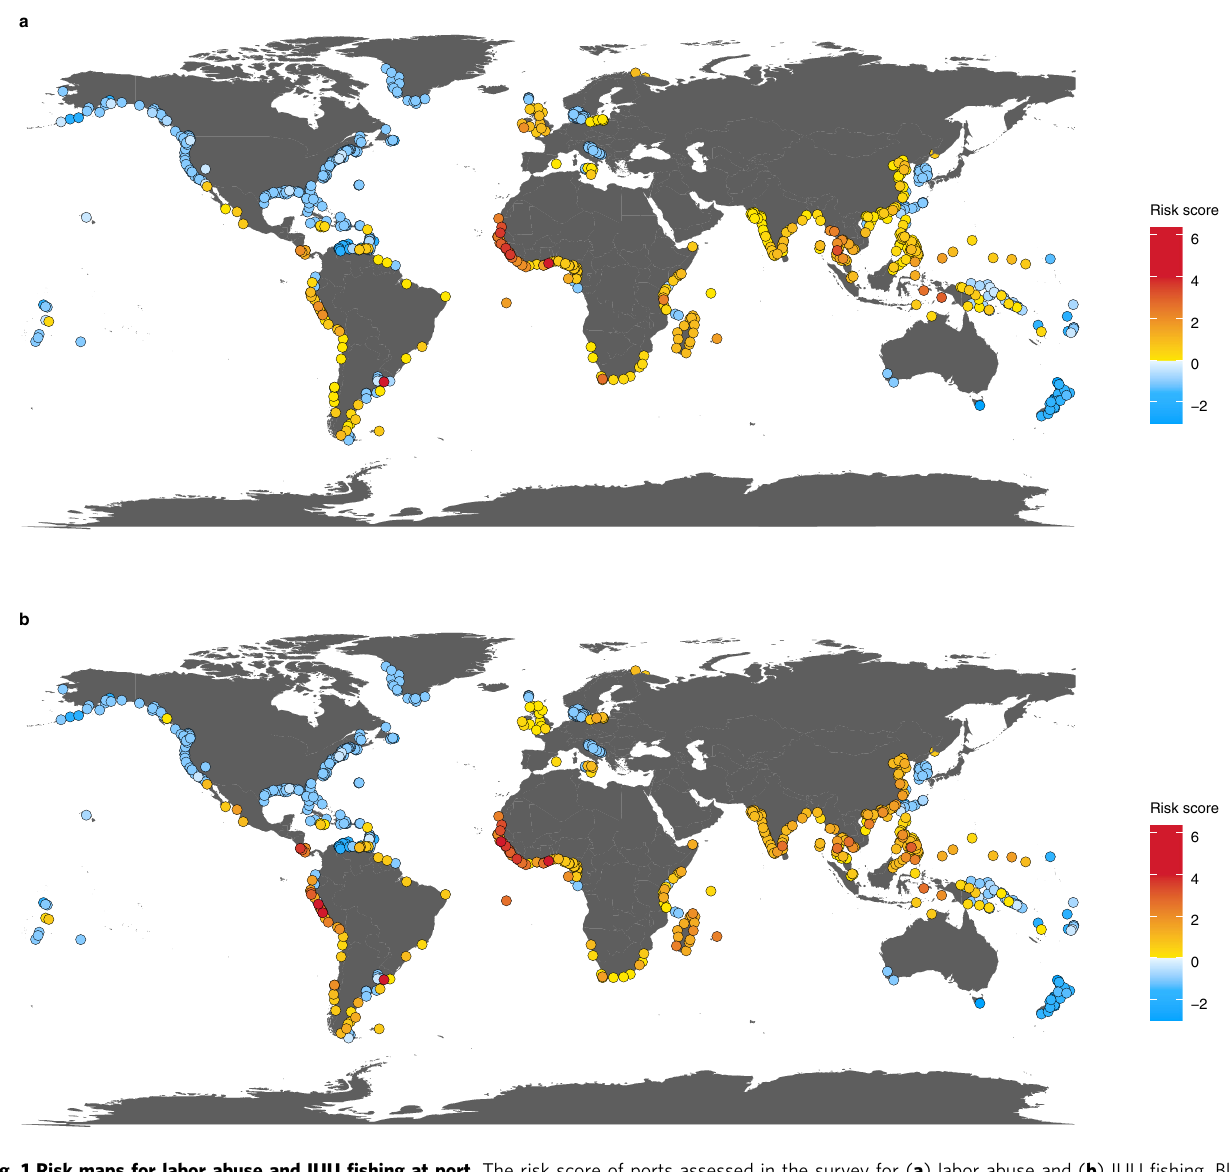
Fig. 1 Risk maps for labor abuse and IUU fi shing at port. The risk score of ports assessed in the survey for ( a ) labor abuse and ( b ) IUU fi shing. Blue indicates lower port risk scores and red denotes